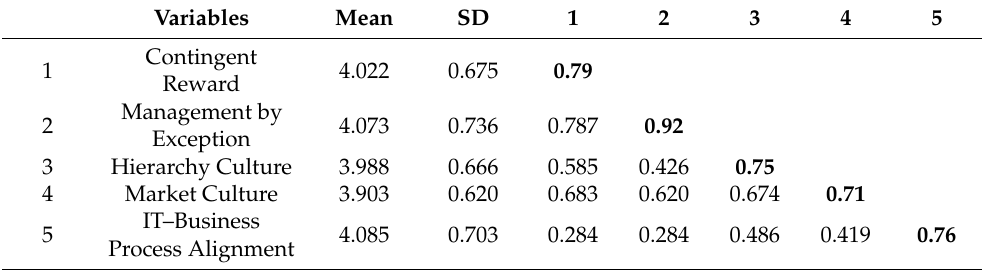
Table 2. Constructs’ mean, SD, and